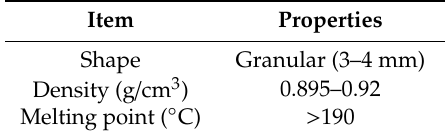
Table 4. Physical properties of polypropylene